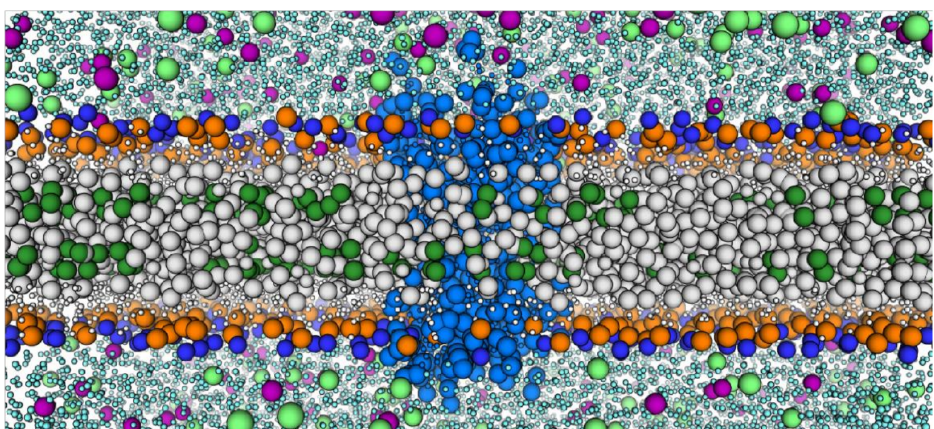
Figure 2. Example of the CCR3 model in a Coarse-Grained System with 30% cholesterol. CCR3 (slate blue) is surrounded by POPC (large gray beads, large dark blue and orange headgroups) and cholesterol (large green beads for the acyl tails, small white beads for the ring system). Water (cyan), sodium ions (lime), and chloride ions (purple) are